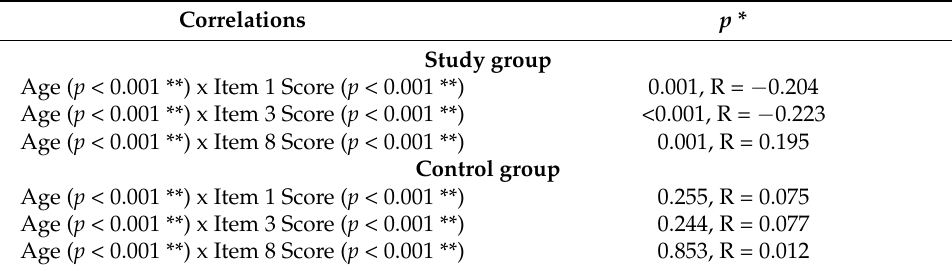
Table 4. Correlations between age and Items 1, 3, and